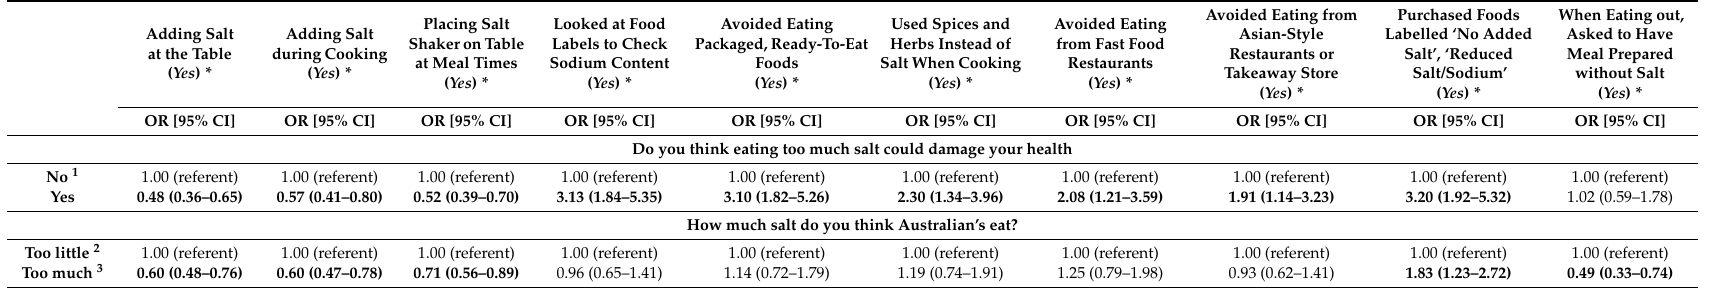
Table 3. Association of parents’ knowledge with specific salt-related behaviours (logistic